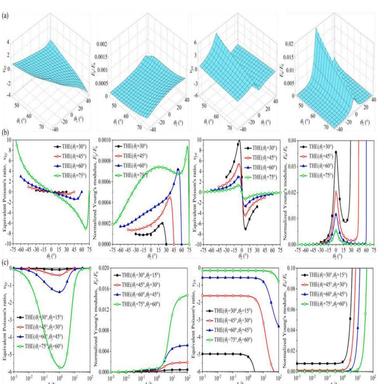
Theoretical analysis of the influence of geometric parameters on elastic constants of 3D DVH lattices with single constitute material, (a) equivalent Poisson's ratio and relative Young's modulus of 3D DVH lattices as functions of θ1 and θ2 (t1/l = t2/l = b/l = 0.1), (b) equivalent Poisson's ratio and normalized Young's modulus of 3D DVH lattices as functions of θ2(t1/l = t2/l = b/l = 0.1), (c) equivalent Poisson's ratio and normalized Young's modulus of 3D DVH lattices as functions of relative thickness t1/